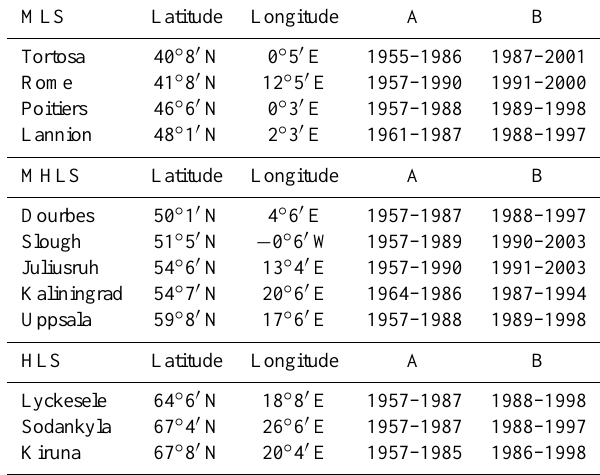
Table 1. List of ionospheric observatories used for the development of the short-term forecasting procedures: the interval of years for which the monthly median measurements are taken into account to calculate the set of regression coefficients (column A) and the interval of years considered to test the reliability of the models (col- umn B) are shown for all the